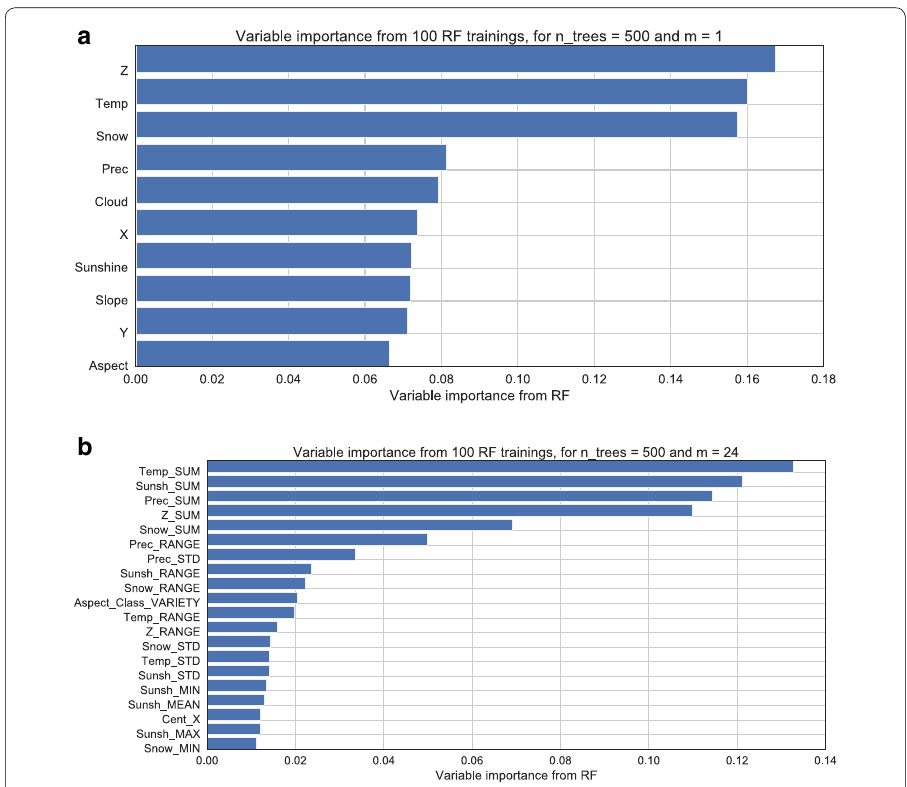
Fig. 19 Variable Importances (VI). See definition of each feature (e.g., Sunshine ) in Appendix 2: Table 9. a For the RF model trained for the estimation of the yearly ground temperature at a depth of 100 cm; b for